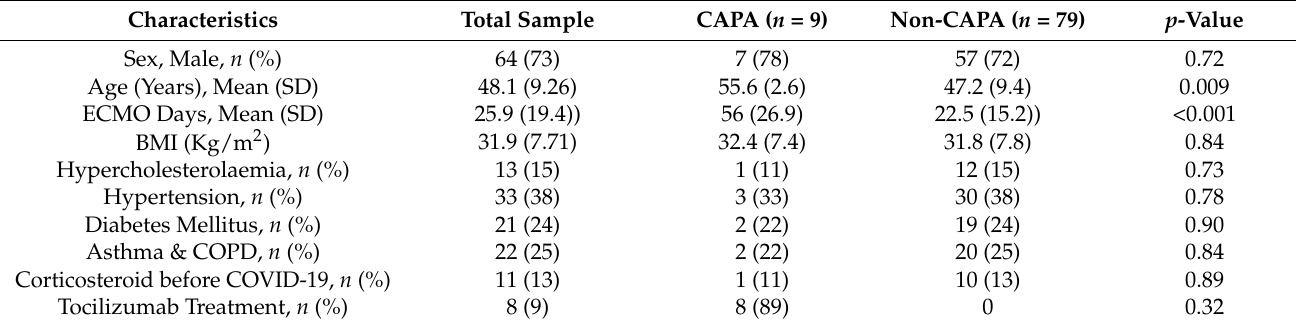
Table 1. Baseline characteristics of CAPA and non-CAPA